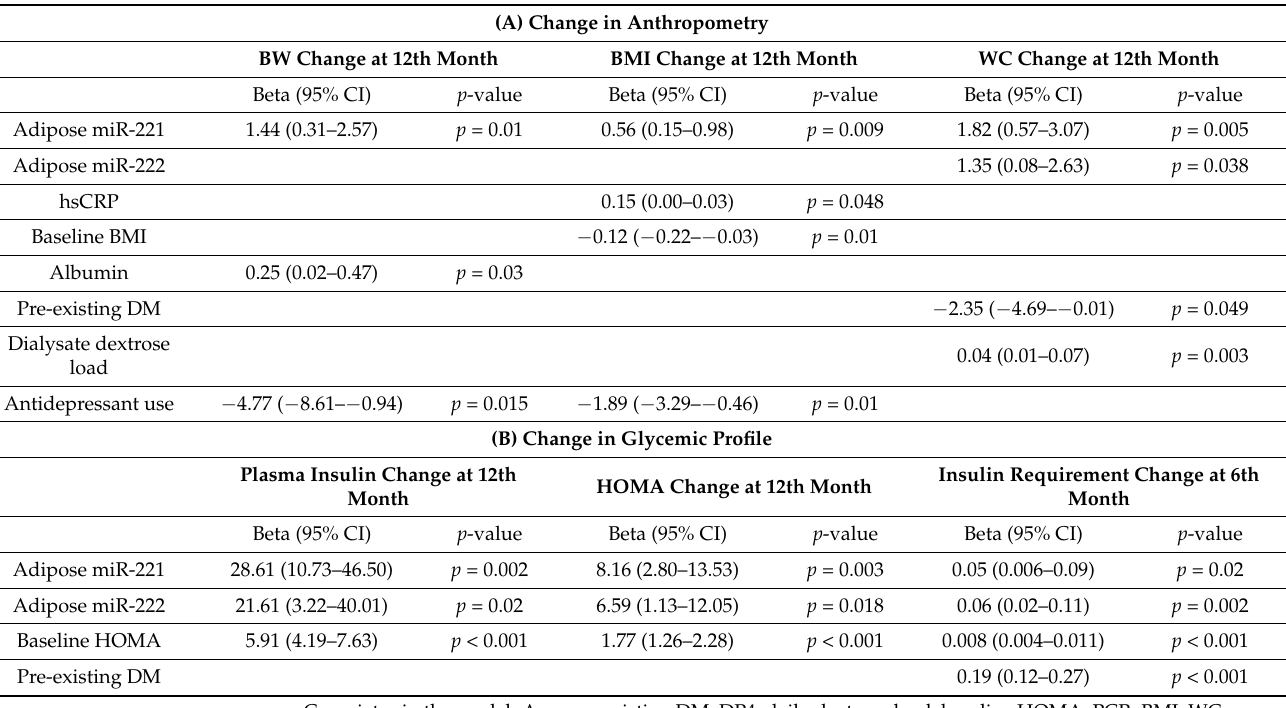
Table 4. Linear regression model for predictors of changes in (A) anthropometry, and (B) glycemic